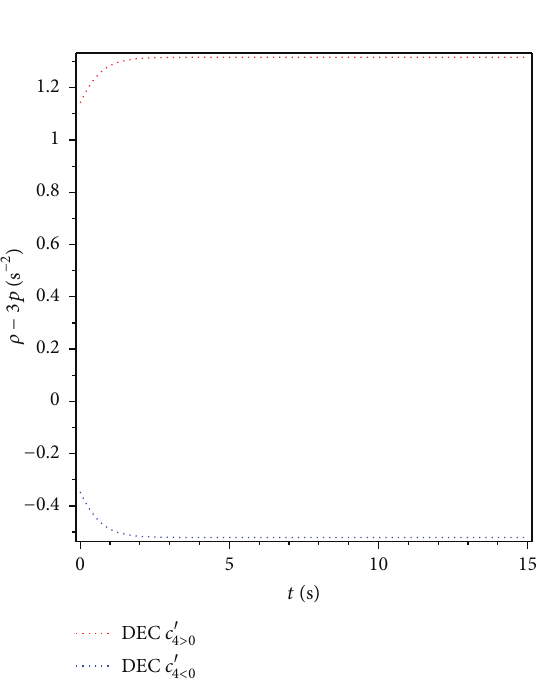
Figure 4: The evolution of DEC for closed model. Here the sign of the three constants 𝑐 󸀠 1 , 𝑐 󸀠 2 , and 𝑐 󸀠 3 has no effect on the evolution of DEC; however, 𝑐 󸀠 4 must have positive value to satisfy the SEC.